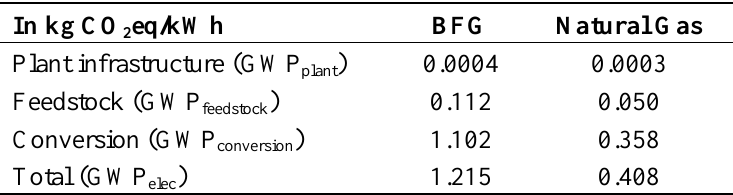
Table 4. Climate change impact (kg CO generation from BFG and natural